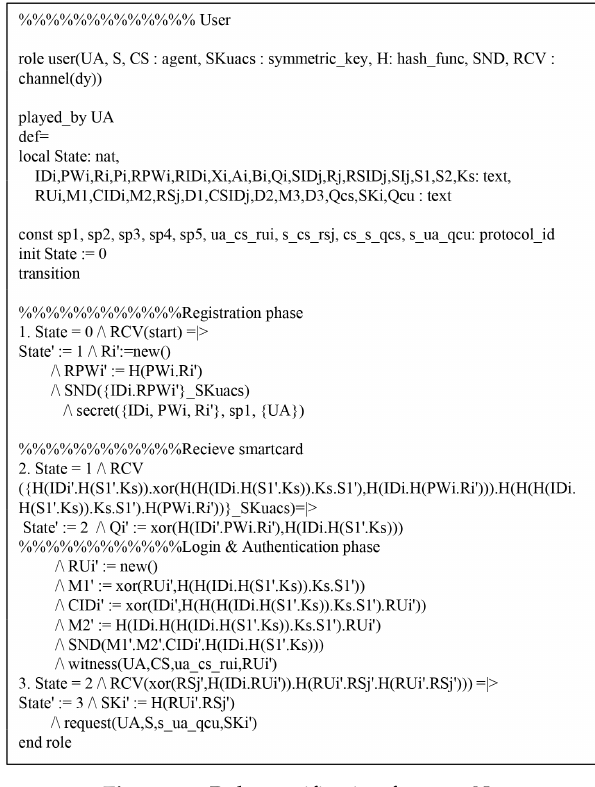
Figure 10. Role specification for user U i .